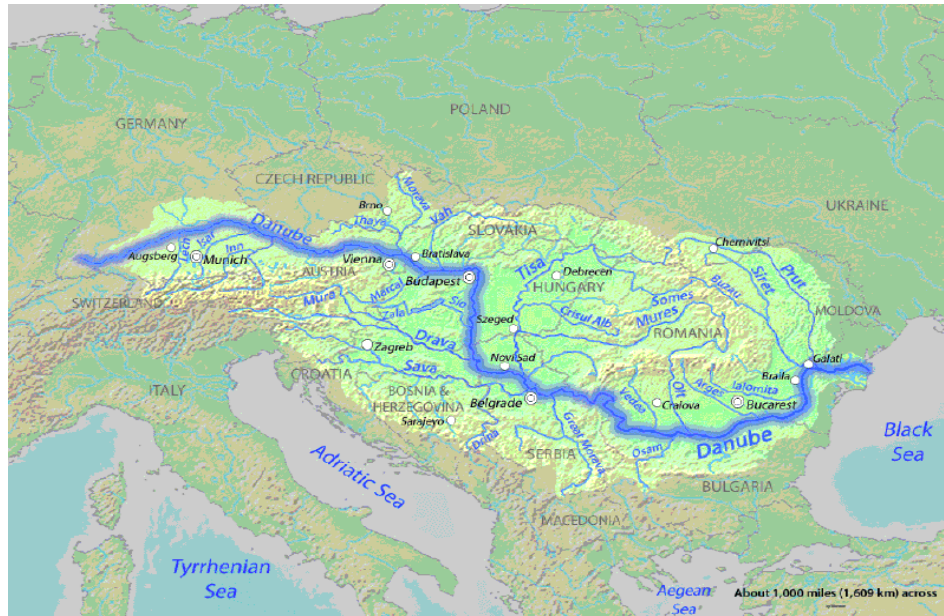
Figure 7. The Danube River Basin in Europe. The relief of the area with the forested hills and mountains mitigates cold winds. Within the Carpathian Mountains, evidence of Neolithic culture has been found. The most logical place for the emergence of this culture is Lepenski Vir, whose position on the Danube's middle waterway during the Ice Age was optimal for expansion, with numerous tributaries coming from the Carpathians. The river is water. Water means life. In addition to the river, the land is usually fertile, the power of the river can be used for watermills, and there are also shops for trade among